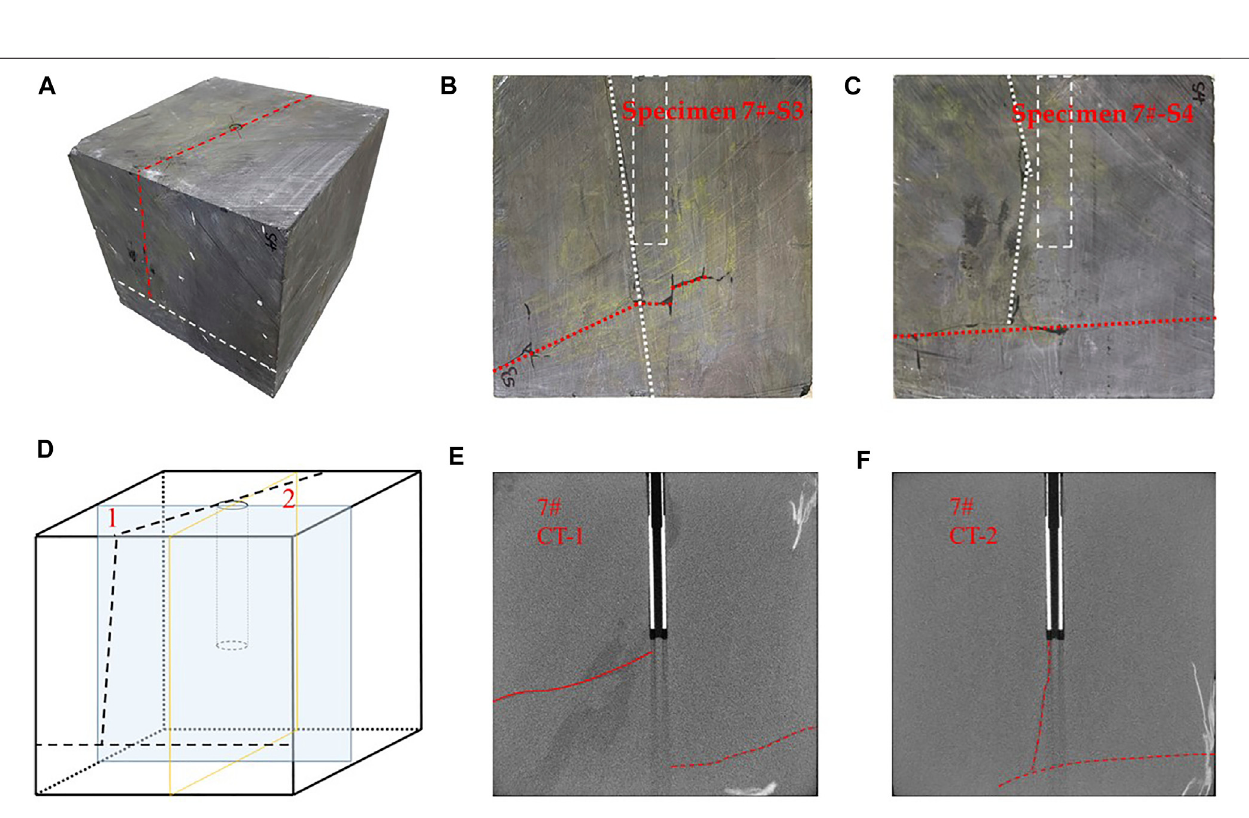
Frontiers in Energy Research |